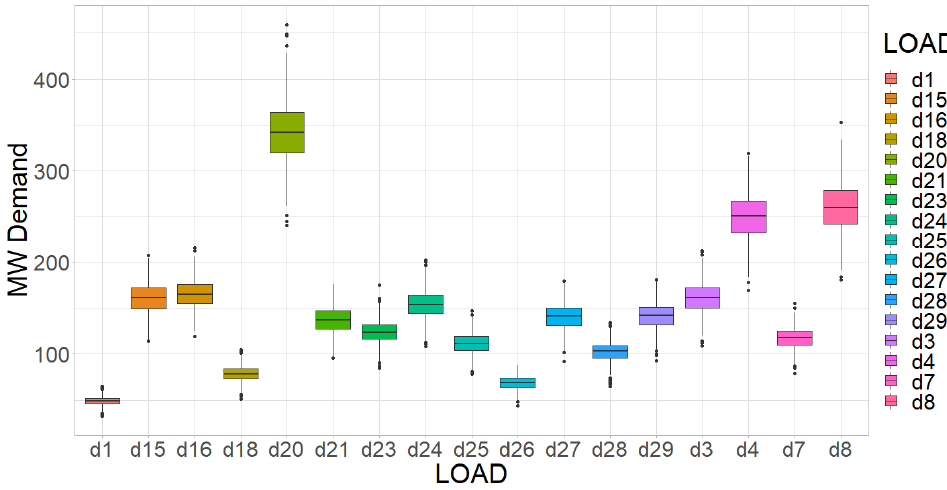
Figure 13. Nodal Demands Distributions (IEEE 39-Bus System).